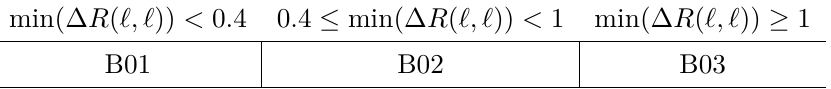
Table 5 . Definition of the search regions used for events with three light leptons, none of which form an OSSF pair